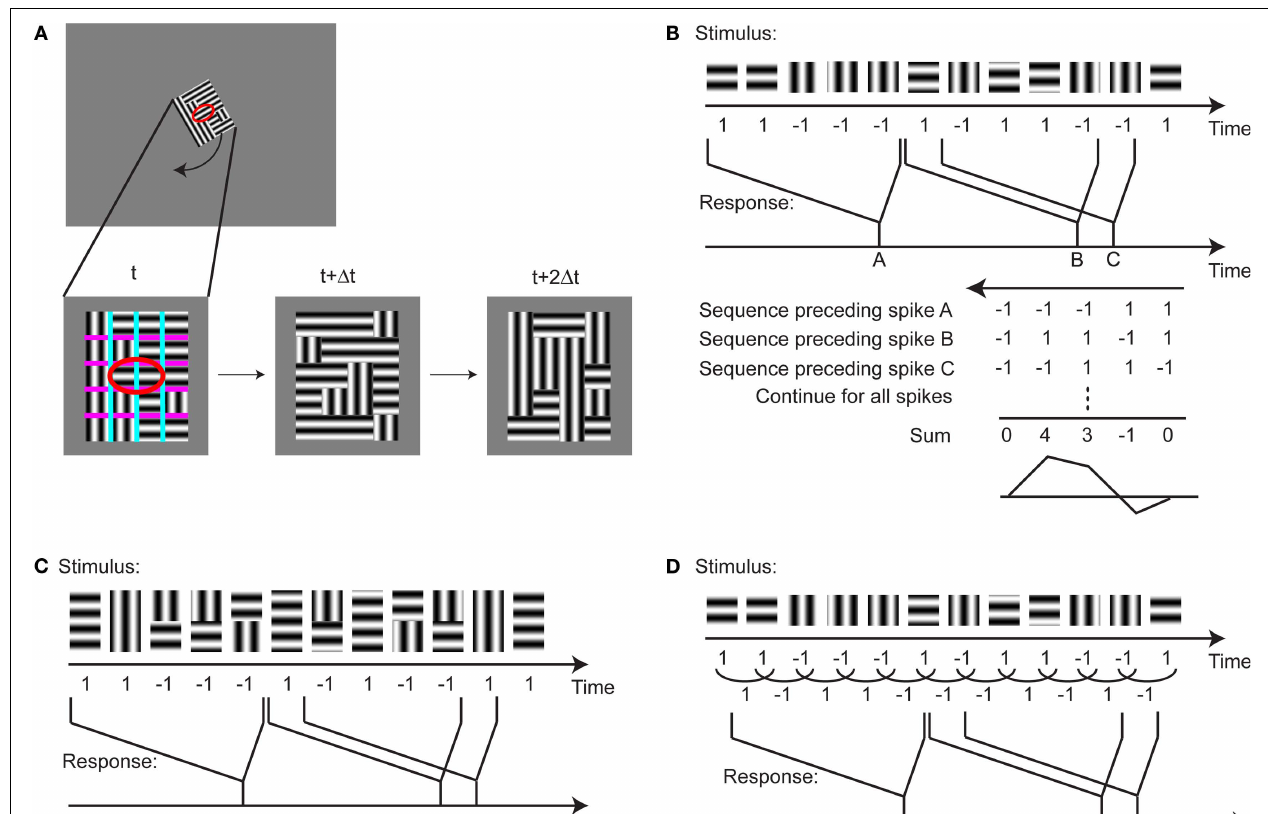
FIGURE 1 | Orientation-discontinuity stimulus and kernel computation. (A) Stimulus setup. A 4 × 5 grid of rectangular regions covered the classical (red ellipse) and non-classical receptive fi eld. The stimulus was aligned with the preferred orientation of the receptive fi eld. Each region contained a static sinusoidal grating with either the preferred or the orthogonal, non-preferred orientation. The orientation in each region changed every 20 ms. Magenta and cyan lines show the region boundaries parallel (magenta) and orthogonal (cyan) to the receptive fi eld; these lines were not part of the stimulus. (B) Computation of a fi rst-order kernel. For each region in the stimulus, the neuron’s spike